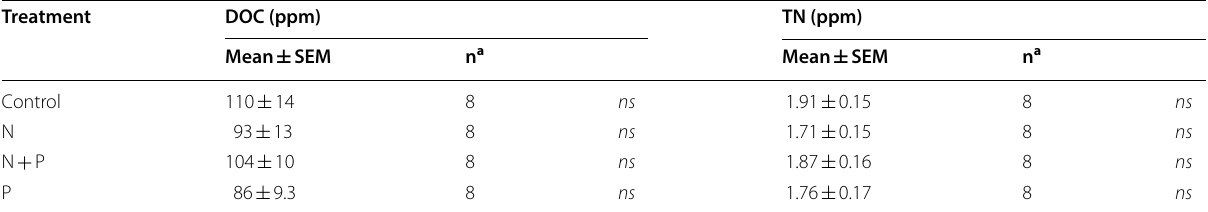
Table 4 Porewater DOC and TN content (ppm) for each treatment Treatment